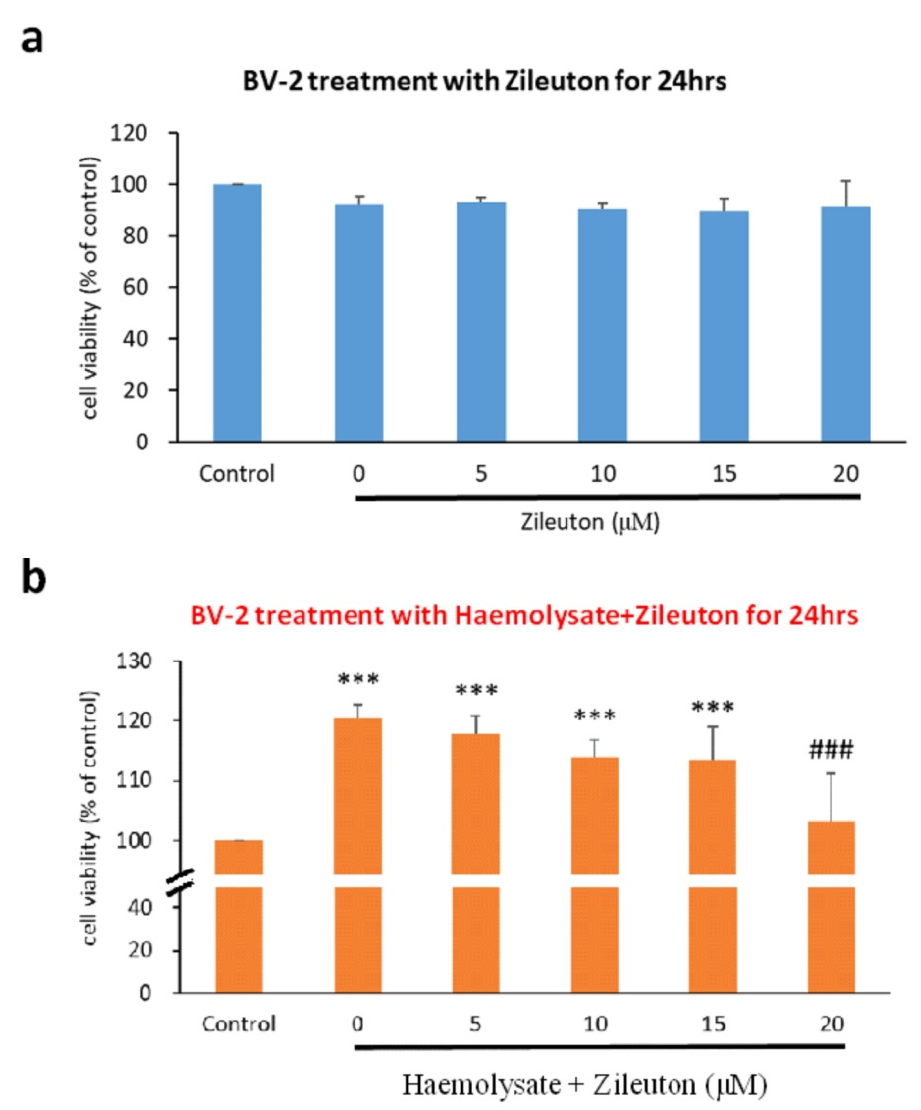
Figure 1. The viability of BV-2 cells. ( a ) The viability of BV-2 cells exposed to zileuton. Differences in the viability of BV-2 cells exposed to different concentrations of zileuton were evaluated via the cell count kit-8 (CCK-8) assay. The x -axis represents the control group and vehicle, as well as different concentrations (5, 10, 15, and 20 µ M) of zileuton; the y -axis represents the cell viability expressed as a percentage relative to the control group. Using the different concentrations of zileuton for 24 h did not inhibit the viability of BV-2 cells ( n = 5). ( b ) The viability of haemolysate-exposed BV-2 cells treated with different concentrations of zileuton. Differences in the viability of haemolysate-exposed BV-2 cells treated with different concentrations of zileuton were evaluated via the CCK-8 assay. The x -axis represents the control group and vehicle, as well as different concentrations (5, 10, 15, and 20 µ M) of zileuton; the y -axis represents the cell viability expressed as a percentage relative to the control group. The haemolysate-exposed BV-2 cells treated with the vehicle or 5, 10, and 15 µ M of zileuton showed significantly higher viability than BV-2 cells in the control group ( p < 0.001). The viability of BV-2 cells in the haemolysate + 20 µ M zileuton group was significantly lower than that of cells in the haemolysate group ( p < 0.001). There was no significant difference in the viability of BV-2 cells between the haemolysate + 20 µ M zileuton group and the control group. The experimental results revealed that 20 µ M of zileuton can inhibit the haemolysate-induced over-proliferation of BV-2 cells (*** p < 0.001 compared with control; ### p < 0.001 compared with haemolysate group, n =